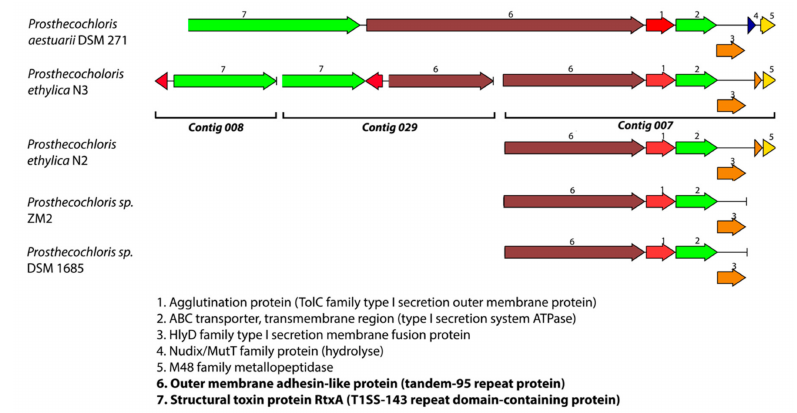
Figure 4. Gene cluster organization and synteny comparison of the large adhesin-like protein-encoded genes, identified in the Prosthecochloris N3 genome and homologues. The genes for large extracellular outer membrane adhesion protein and RtxA discussed in the text are marked in